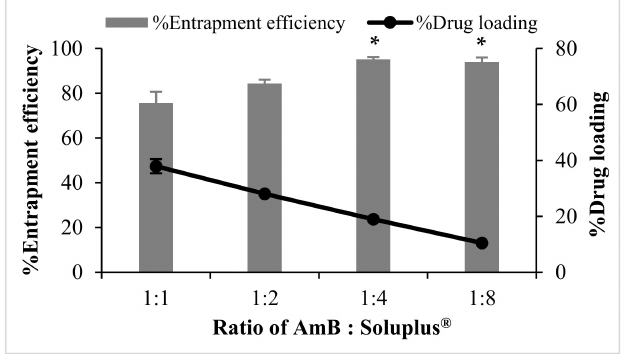
Figure 2. Entrapment e ffi ciency (%EE) and drug loading (%DL) of AmB-PM prepared with di ff erent weight ratios of drug and polymers ( n = 3). Data are presented as mean ± SD, ( n = 3). * indicate AmB-PM (1:4) and (1:8) significantly di ff erent to AmB-PM (1:1) and (1:2) ( p < 0.05).